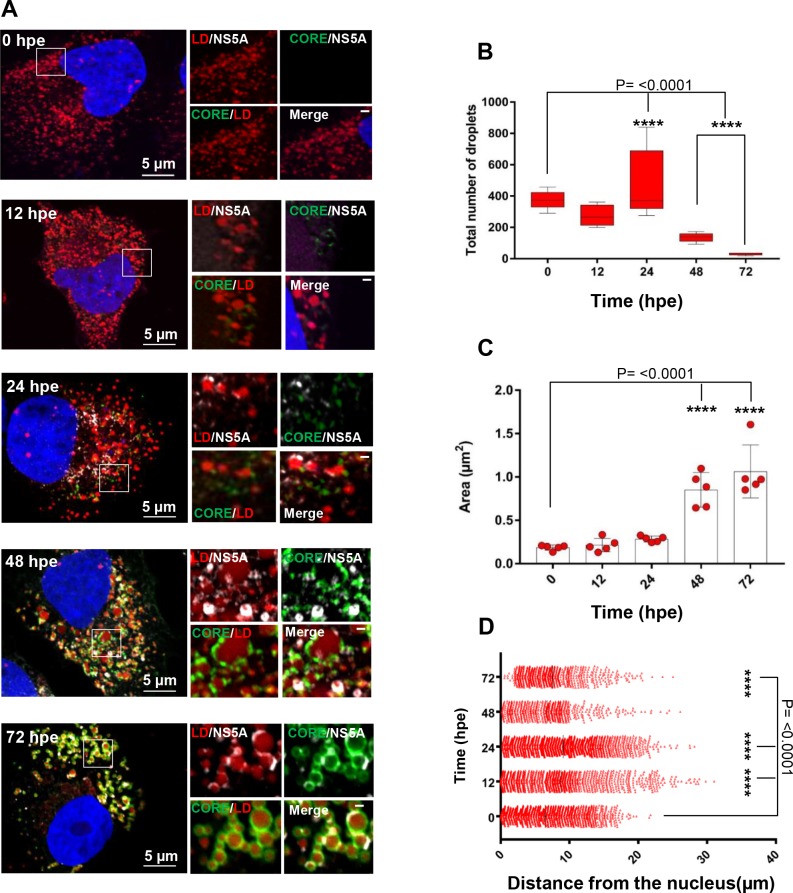
Time-course immunofluorescence analysis of LDs, NS5A and Core in WT infected cells.Huh7.5 cells were electroporated with an in vitro transcript of mJFH-1 WT. At the indicated h.p.e. cells were fixed and stained with anti-NS5A and Core antibodies, BODIPY 558/568-C12, and DAPI and imaged by Airyscan microscopy (A). Spatial data for LDs were determined from 10 cells for each time point using Fuji. These data were used to determine the number of LDs per cell (B), the average size of LDs (C) and the distance of each LD from nucleus at different time points (D). **** indicates significant difference (P<0.0001) from the results for LDs in untransfected cells. The scale bars are 5μm and 0.5 μm, respectively.